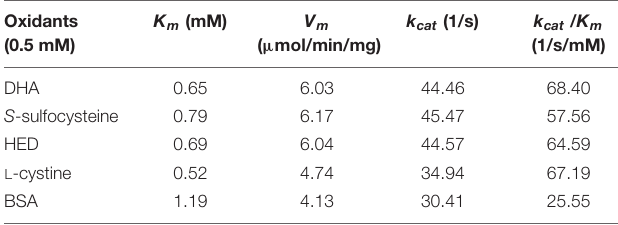
TABLE 5 | The kinetics parameters of the